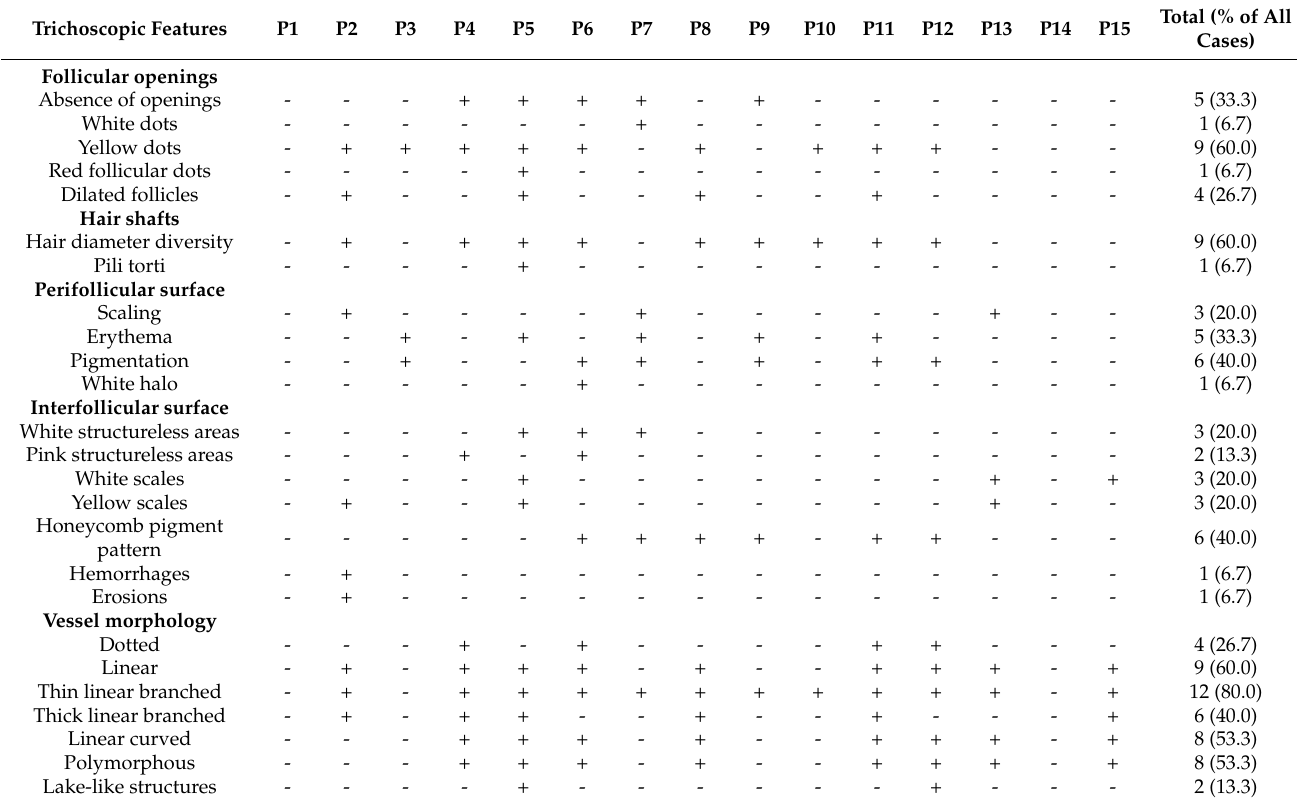
Table 3. Trichoscopic findings in patients with dermatomyositisi (P1–P15—patient